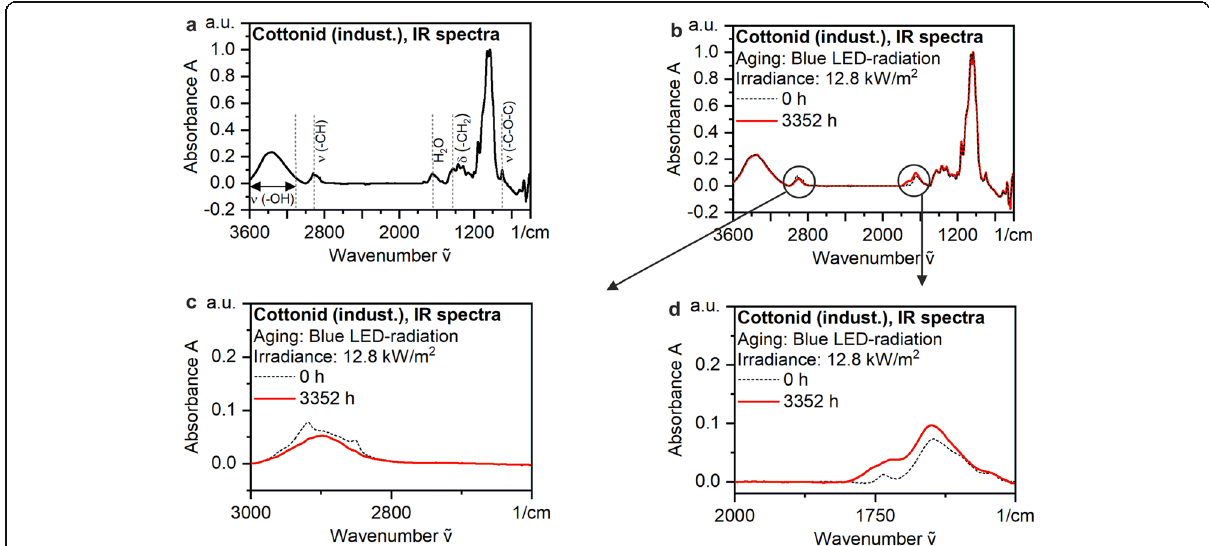
Fig. 4 Infrared (IR) spectra of industrial Cottonid material (Ernst Krueger): a In initial condition with peak definition of raw material cellulose, and b